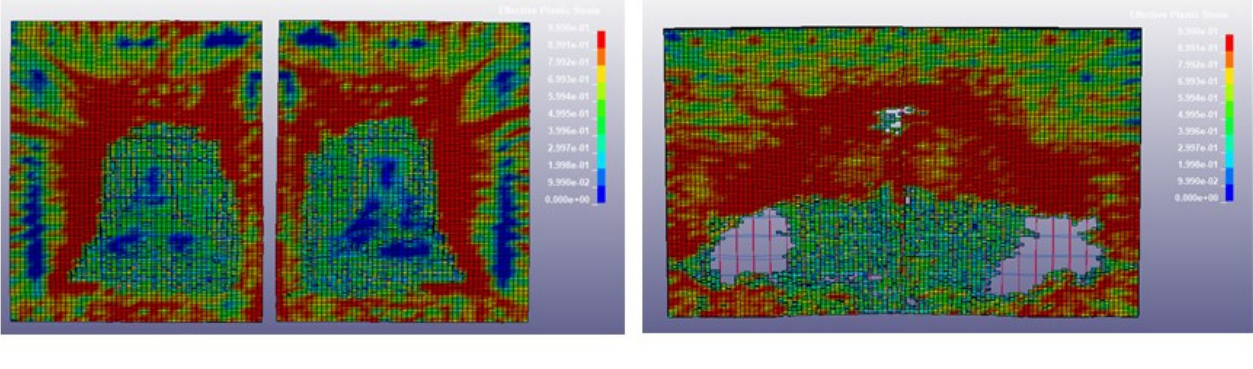
Figure 21. Post-blast concrete crushing at the supports scenario (iii): rigid supports ( left ) and 8 × φ 64 mm EACs ( right ).